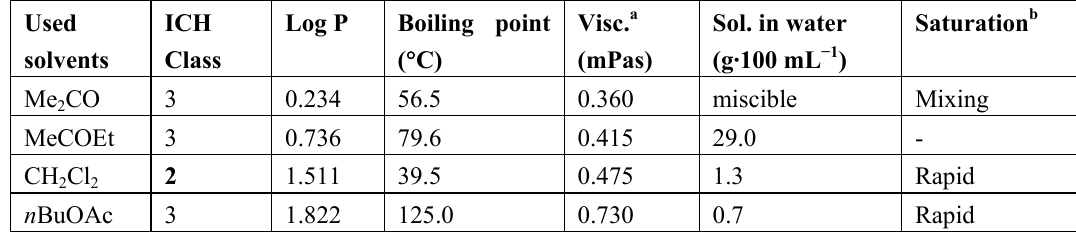
Table 1. Physicochemical properties of the organic solvents used.